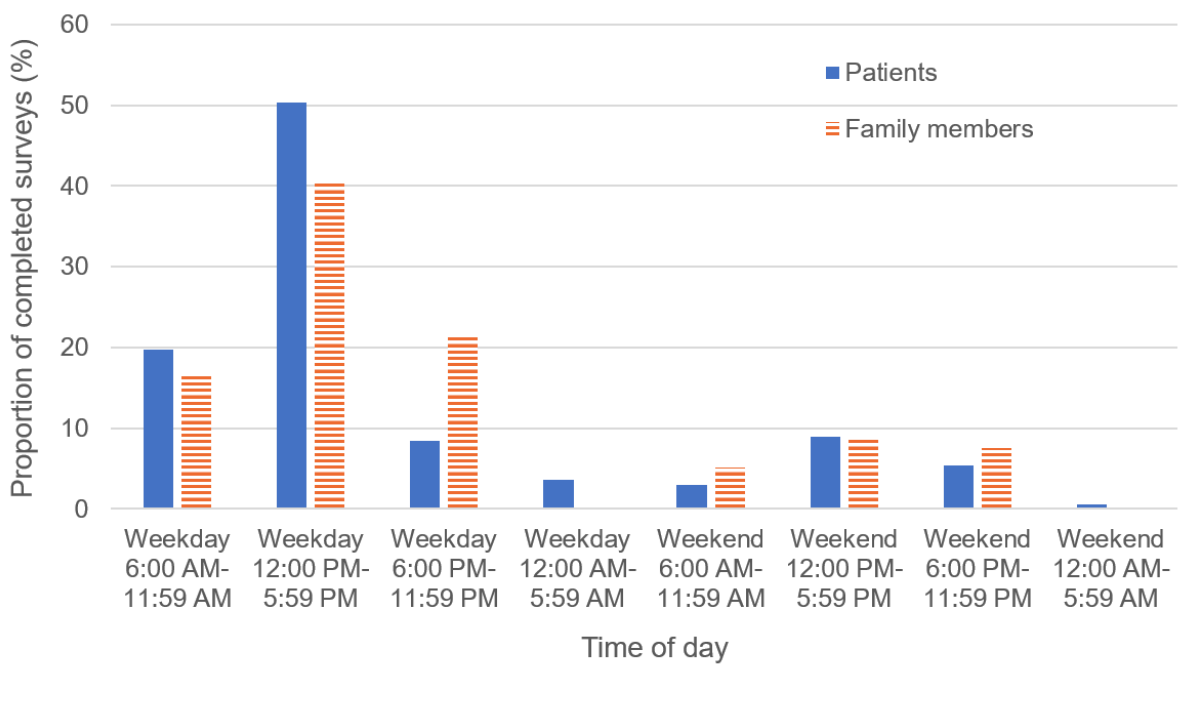
Figure 1. Timing of survey